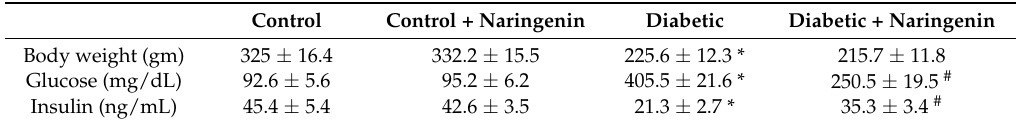
Table 1. Effects of naringenin on body weight, blood glucose and serum insulin levels in the rats group as indicated. Control Control + Naringenin Diabetic Diabetic + Naringenin Body weight (gm)